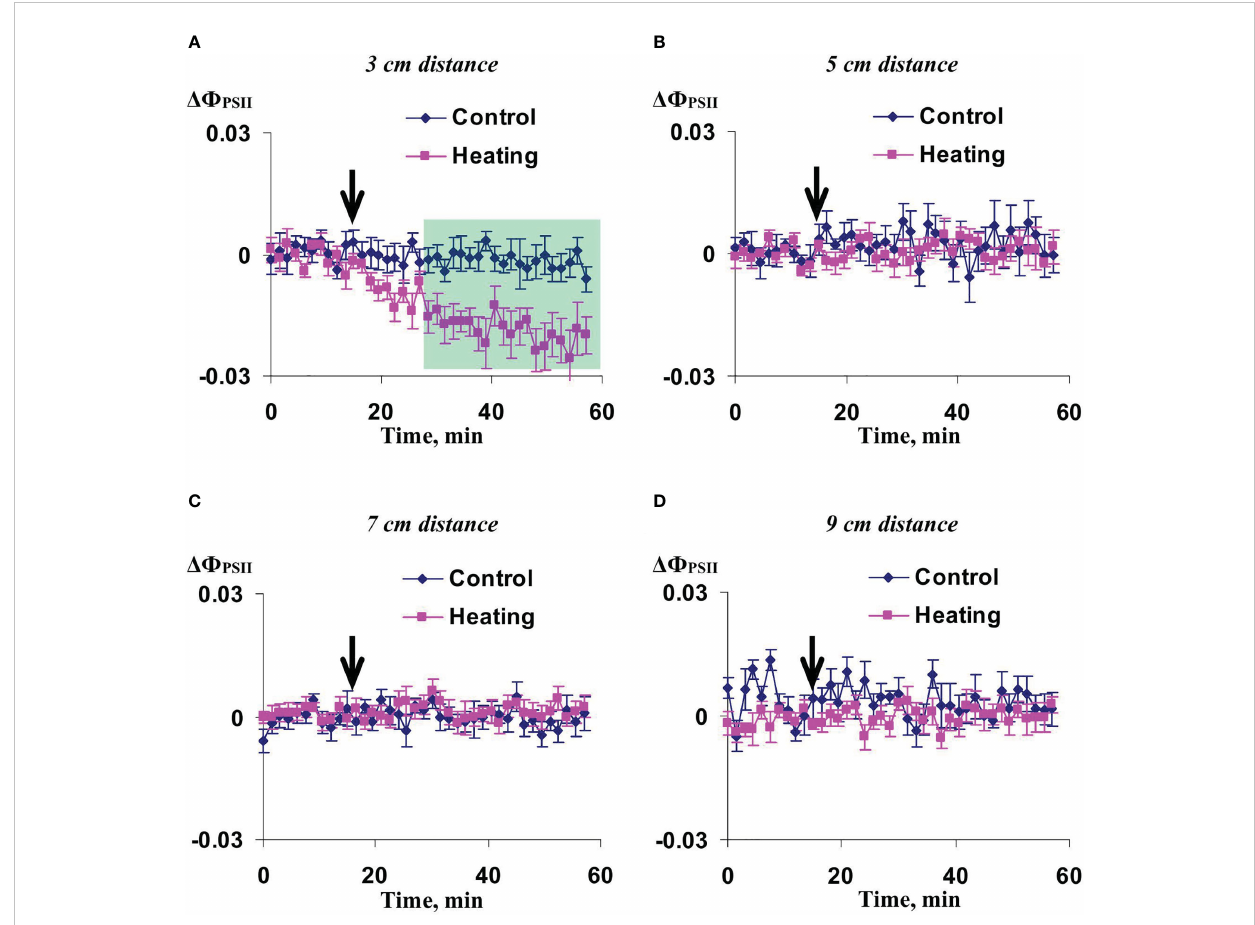
water fl ux from cells to xylem vessels under the irritation (e.g.,